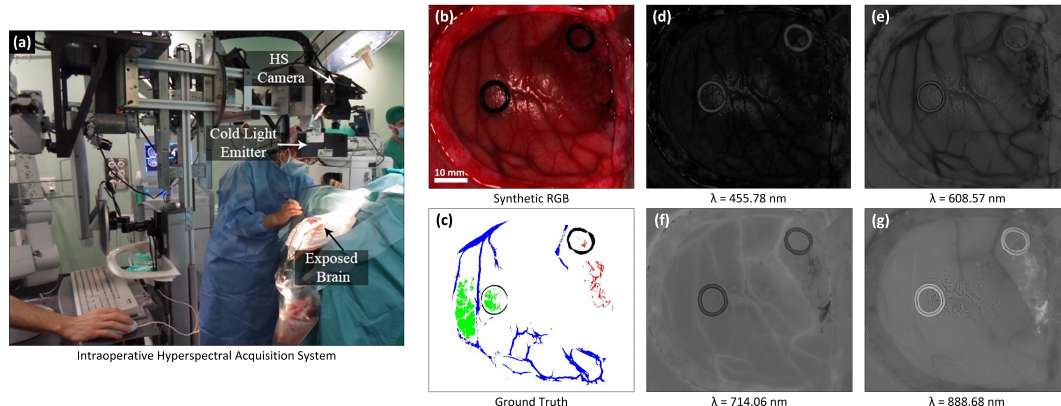
Figure 1. ( a ) HELICoiD intraoperative HS acquisition system (reproduced from [28]). ( b ) Synthetic RGB image of the brain tissue extracted from the hyperspectral cube. The marker has an external diameter of 10 mm. ( c ) Annotated ground truth obtained with the semi-automated Spectral Angle Mapper (SAM) labeling tool. Normal, tumor, blood vessels and background classes are represented in green, red, blue, and black color, respectively. White pixels correspond with non-labeled data. ( d – g ) Examples of four gray-scale band representations for different wavelengths in the employed spectral range. These wavelengths were selected by visual inspection of this HS cube in order to illustrate the four of the most different spectral